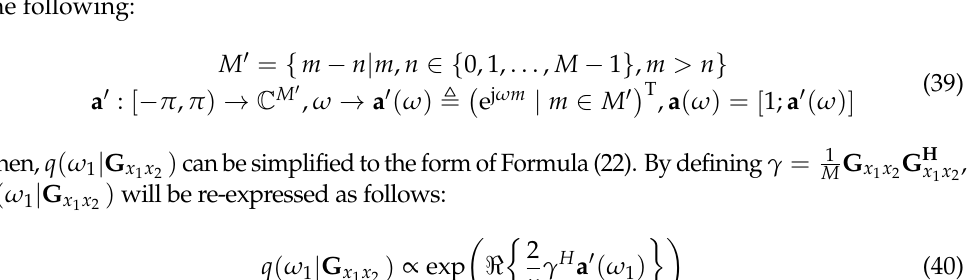
Algorithm 1. Next, a specific initialization scheme is